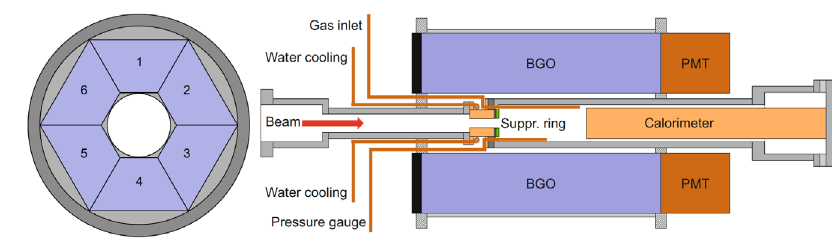
Figure 1. Experimental setup used at LUNA for the study of the 22 Ne( α,γ ) 26 Mg reaction with BGO